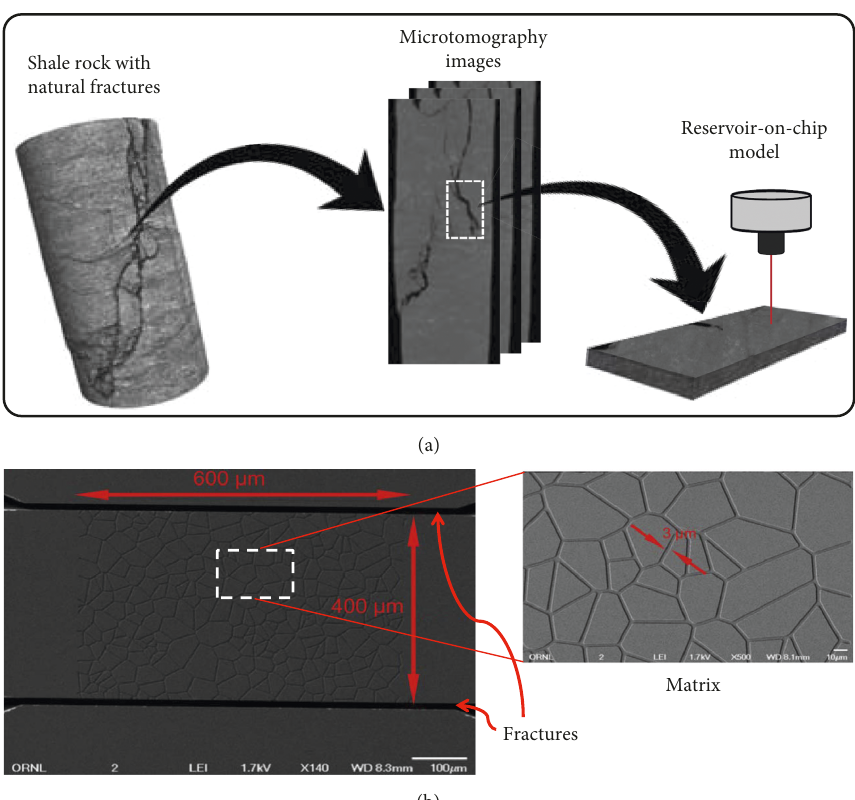
Figure 11: Schematic illustrating (a) a reservoir-on-chip framework and (b) a micromodel with a network of fractures and heterogeneous pores (inset) (adapted after [252] and [248],